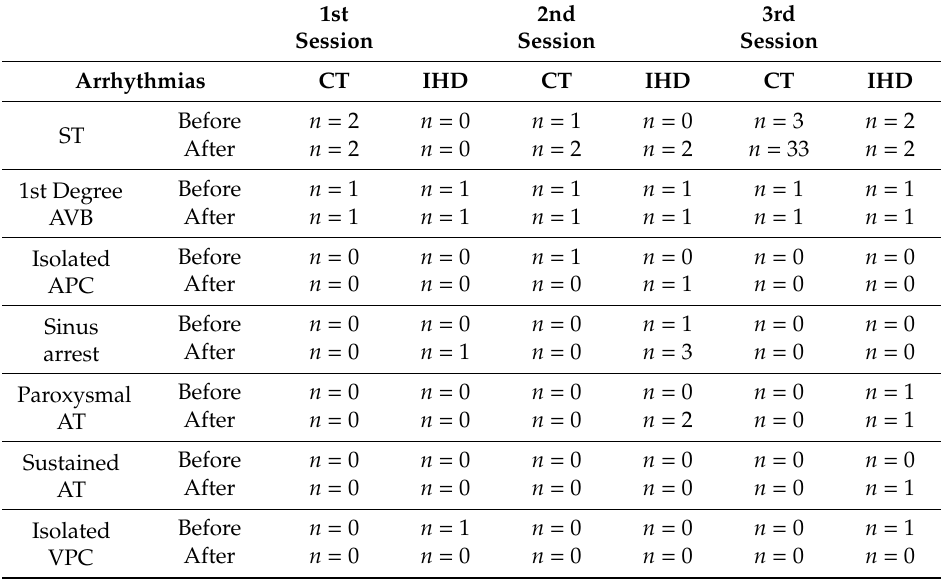
ST: sinus tachycardia; AVB: atrioventricular block; APC: atrial premature contraction; AT: atrial tachycardia; VPC: ventricular premature contraction.